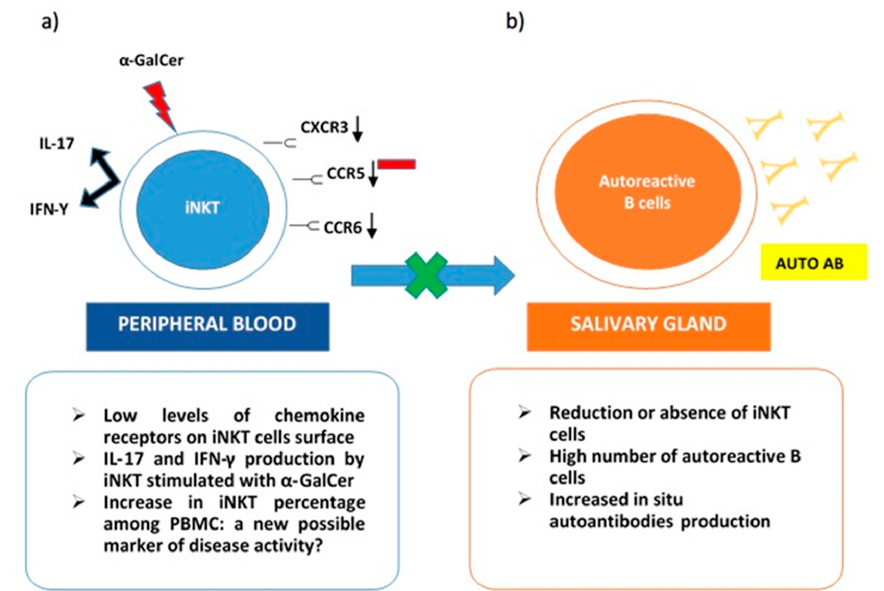
Figure 1. iNKT cells in Sjogren Syndrome. ( a ) in peripheral blood iNKT express low levels of chemokine receptors (CXCR3, CCR6, CCR5) on their surface. This could explain their reduced presence in salivary glands due to impaired migration. iNKT from pSS peripheral blood samples stimulated with a-GalCer produce both IL-17 and IFN- γ ; ( b ) in the salivary gland, reduction or absence of iNKT cells determines the loss of their role as negative regulators on autoreactive B cells and the consequent in situ production of